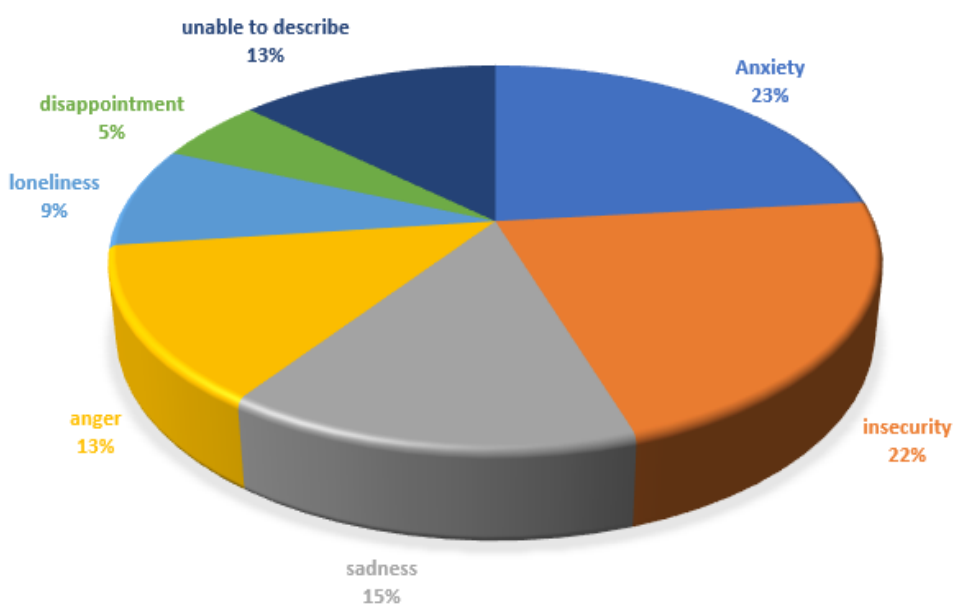
Figure 1. Feelings experienced by patients 2 to 3 times per week.